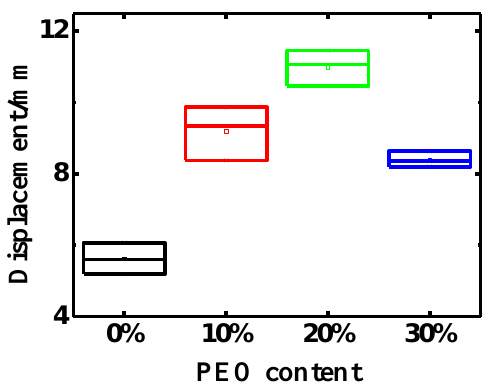
Figure 5. Peak − to − peak displacement of PEO/Nafion − IPMC with varying PEO contents. Figure 5. Peak-to-peak displacement of PEO/Nafion-IPMC with varying PEO contents.